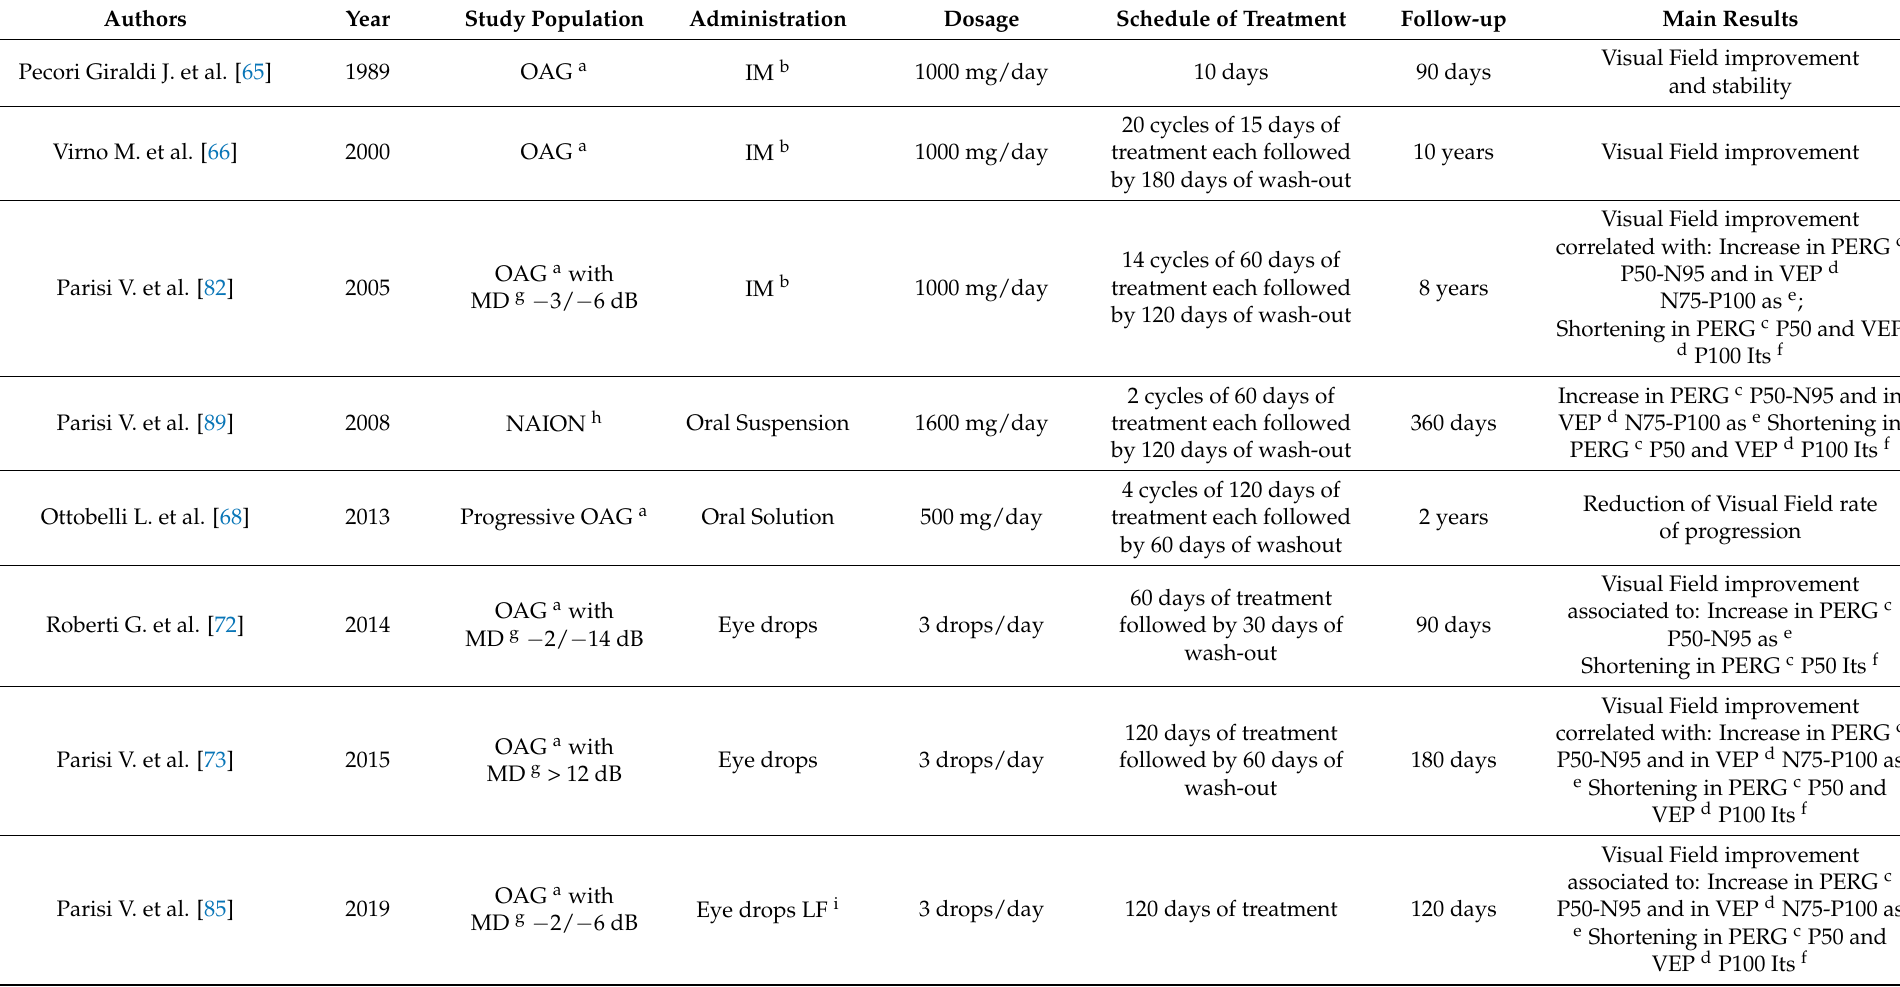
Table 3. Summary of clinical studies evaluating the effects of citicoline in human ophthalmological neurodegenerative disease: psychophysical